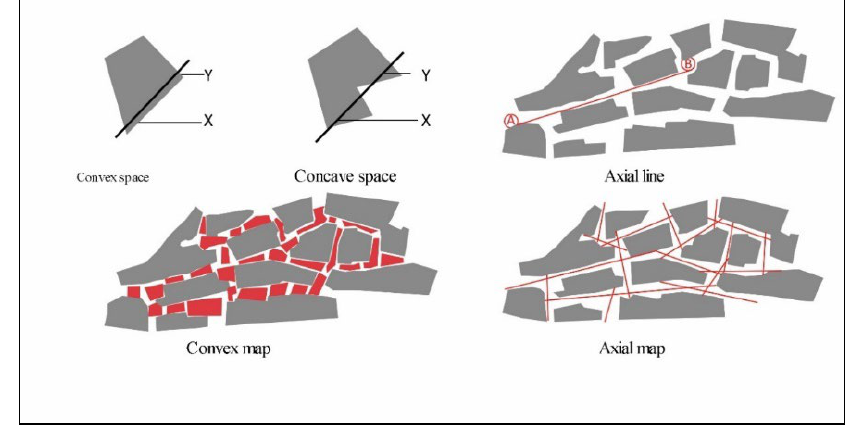
Figure 4 Space syntax tools (Hillier, 1984).